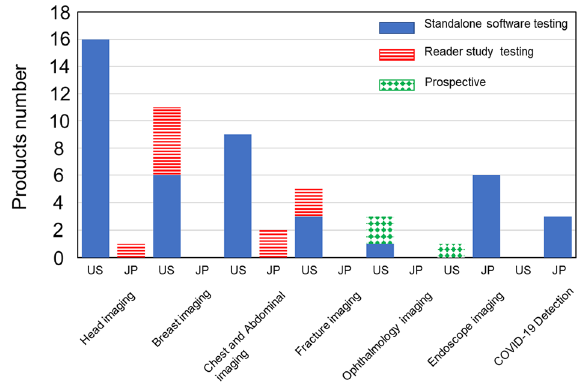
Figure 2. Number of approved AI/ML-based CAD devices in the USA and Japan.